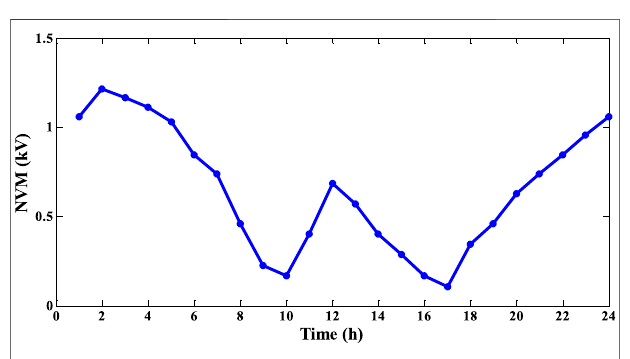
FIGURE 9 | Time sequence fl uctuation of NVM.